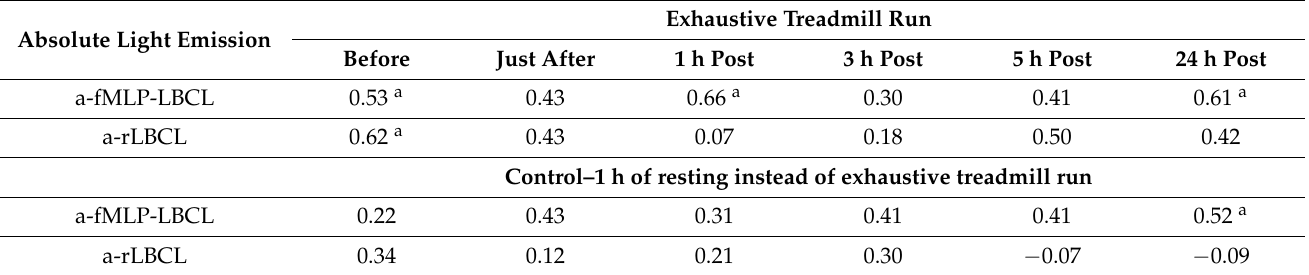
Table 10. Correlations ( δ ) between absolute rLBCL, fMLP-LBCL, and the total number of white blood cells (WBC) in the assayed blood sample collected before, just after and at 1 h, 3 h, 5 h and 24 h post-exhaustive treadmill run.